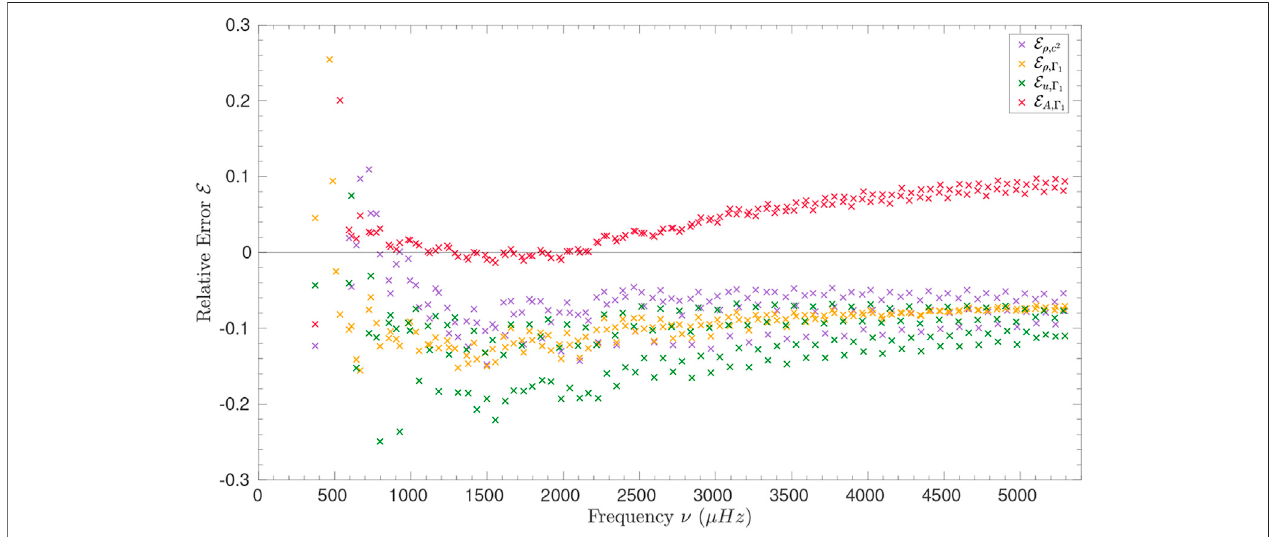
FIGURE 4 | Illustration of the veri fi cation of the integral relation between relative frequency differences and relative structure differences for solar models including varioustransports of the mixing of chemicals, using Eq. 18 , using models from Buldgen et al.(2017b) and various structural pairs, namely ( ρ , c 2 ) ( ρ , Γ 1 ) ( u , Γ 1 ) and ( A , Γ 1